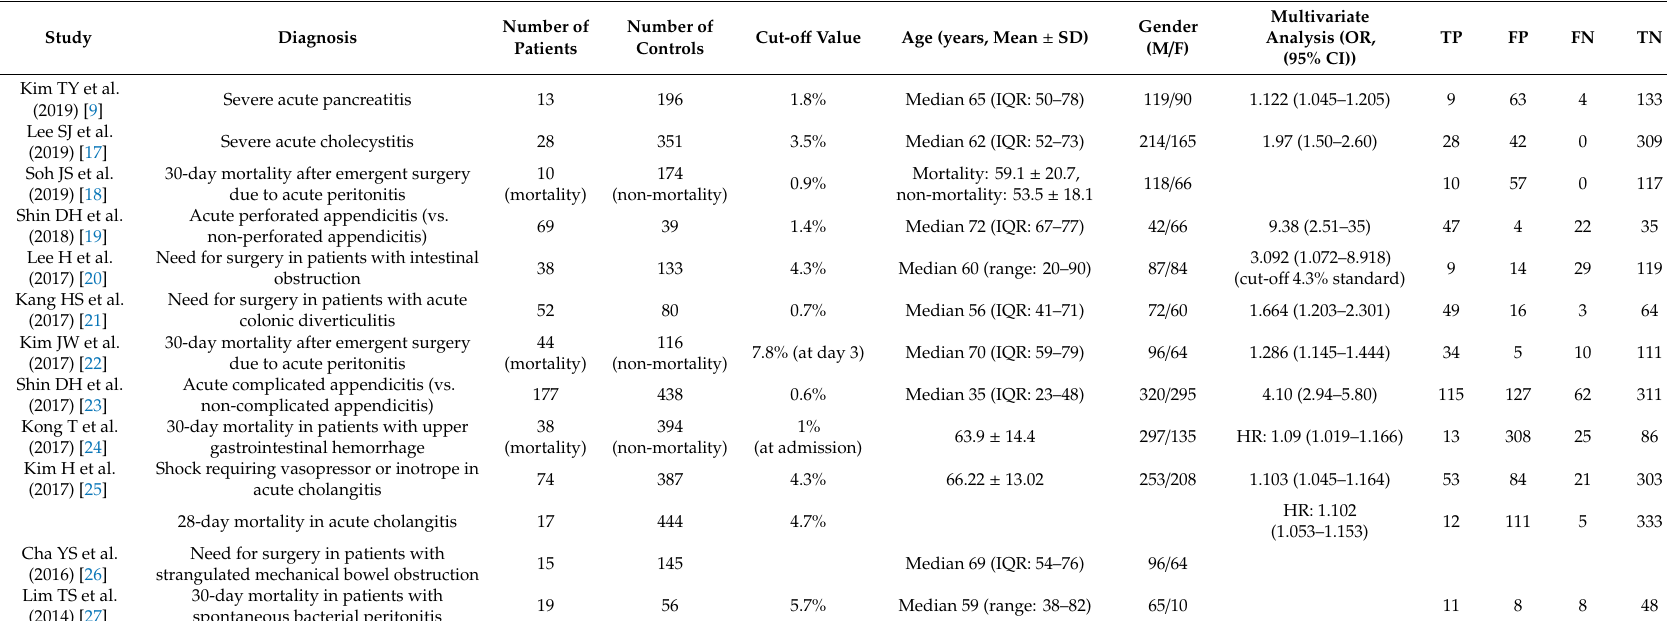
Table 1. Summary of characteristics of included